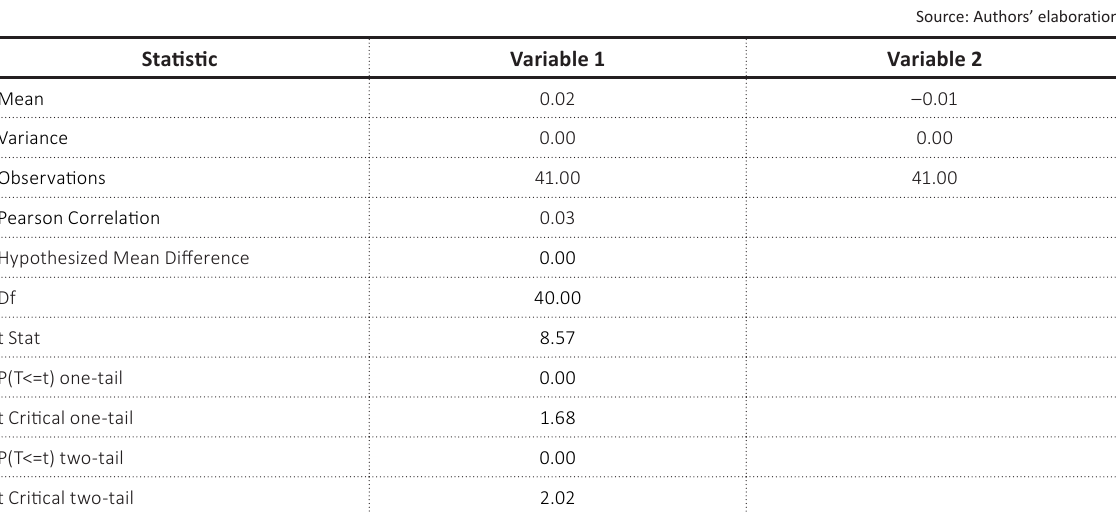
Table 7. T- test results (value-weighted